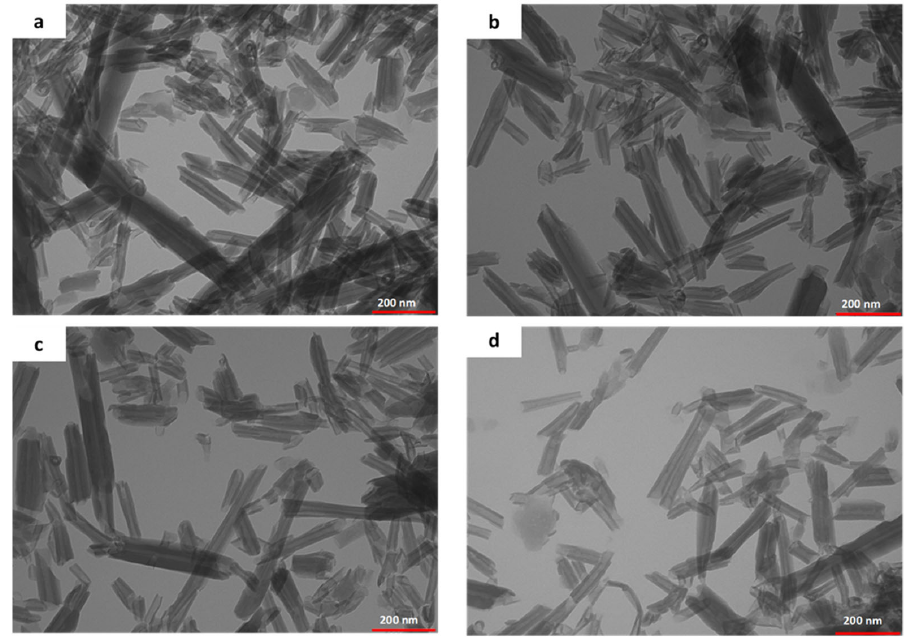
Figure 8. TEM images at 100 kX magnification of H ( a ), H_HCl_8M ( b ), H_H 2 SO 4 _0.5M ( c ), and H_NaOH_0.5M ( d ).